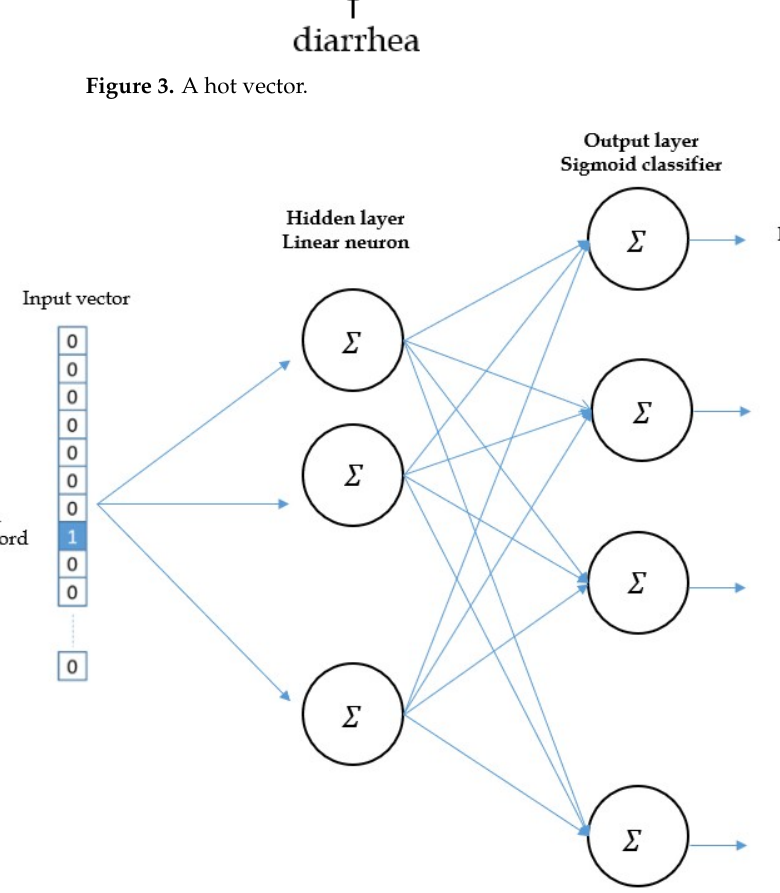
Figure 3. A hot vector.